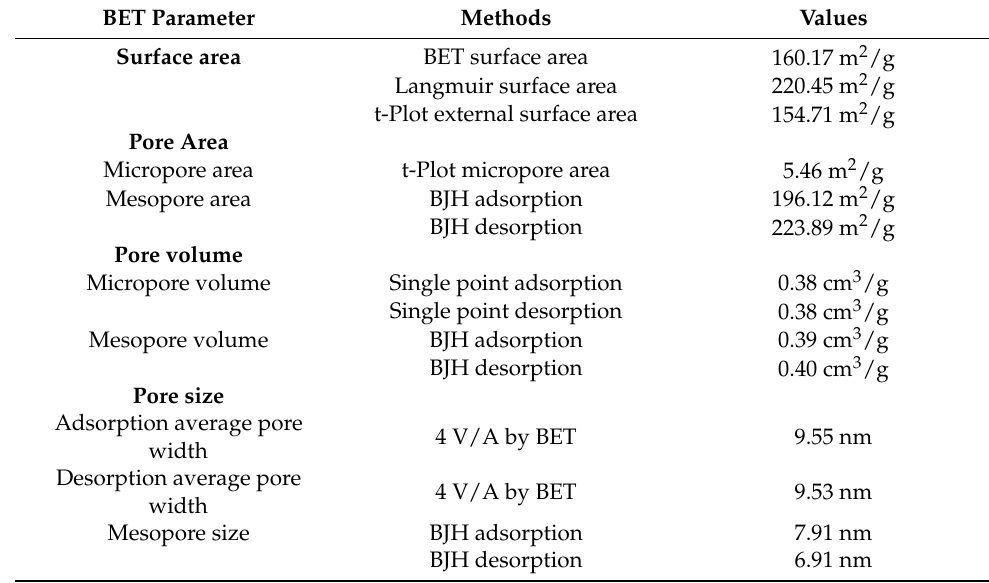
Figure 4. BET Nitrogen adsorption–desorption isotherms and pore size distribution curve. Table 2. BET Surface analysis parameters of CNF-AgMgOnHaP adsorbent.